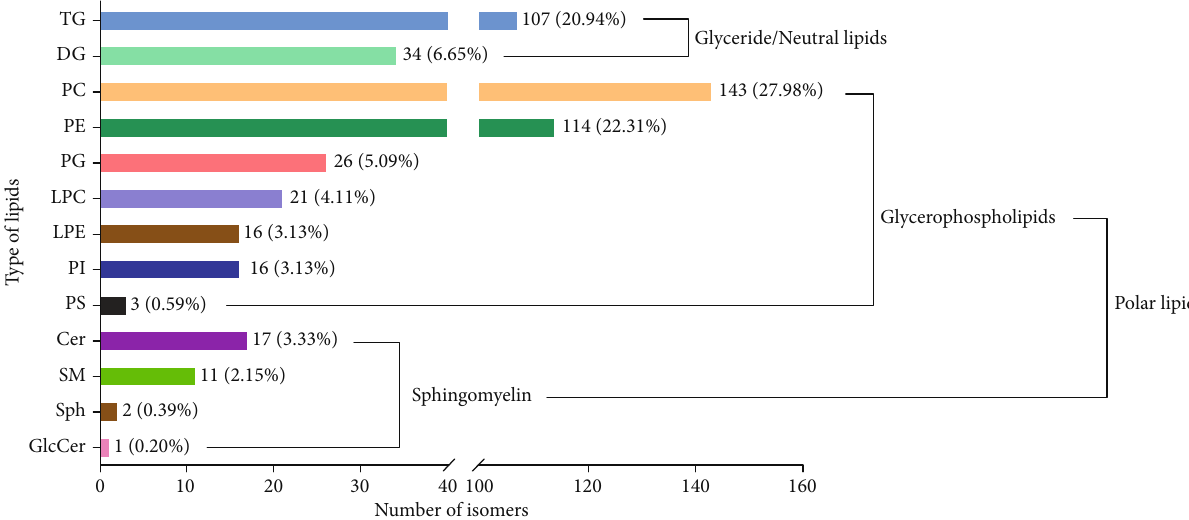
Figure 6: Lipid subclass types, isomer numbers, and percentages identi fi ed in the ovaries of C. quadricarinatus fed diets with di ff erent phospholipid sources for 10 weeks. TG = triacylglycerol; DG = diacylglycerol; PC = phosphatidylcholine; PE = phosphatidylethanolamine; PG = phosphatidylglycerol; LPC = lysophosphatidylcholine; LPE = lysophosphatidylcholine; PI = phosphatidylinositol; PS = phosphatidylserine; Cer = ceramide; SM = sphingomyelins; Sph = sphingosine; GlcCer =